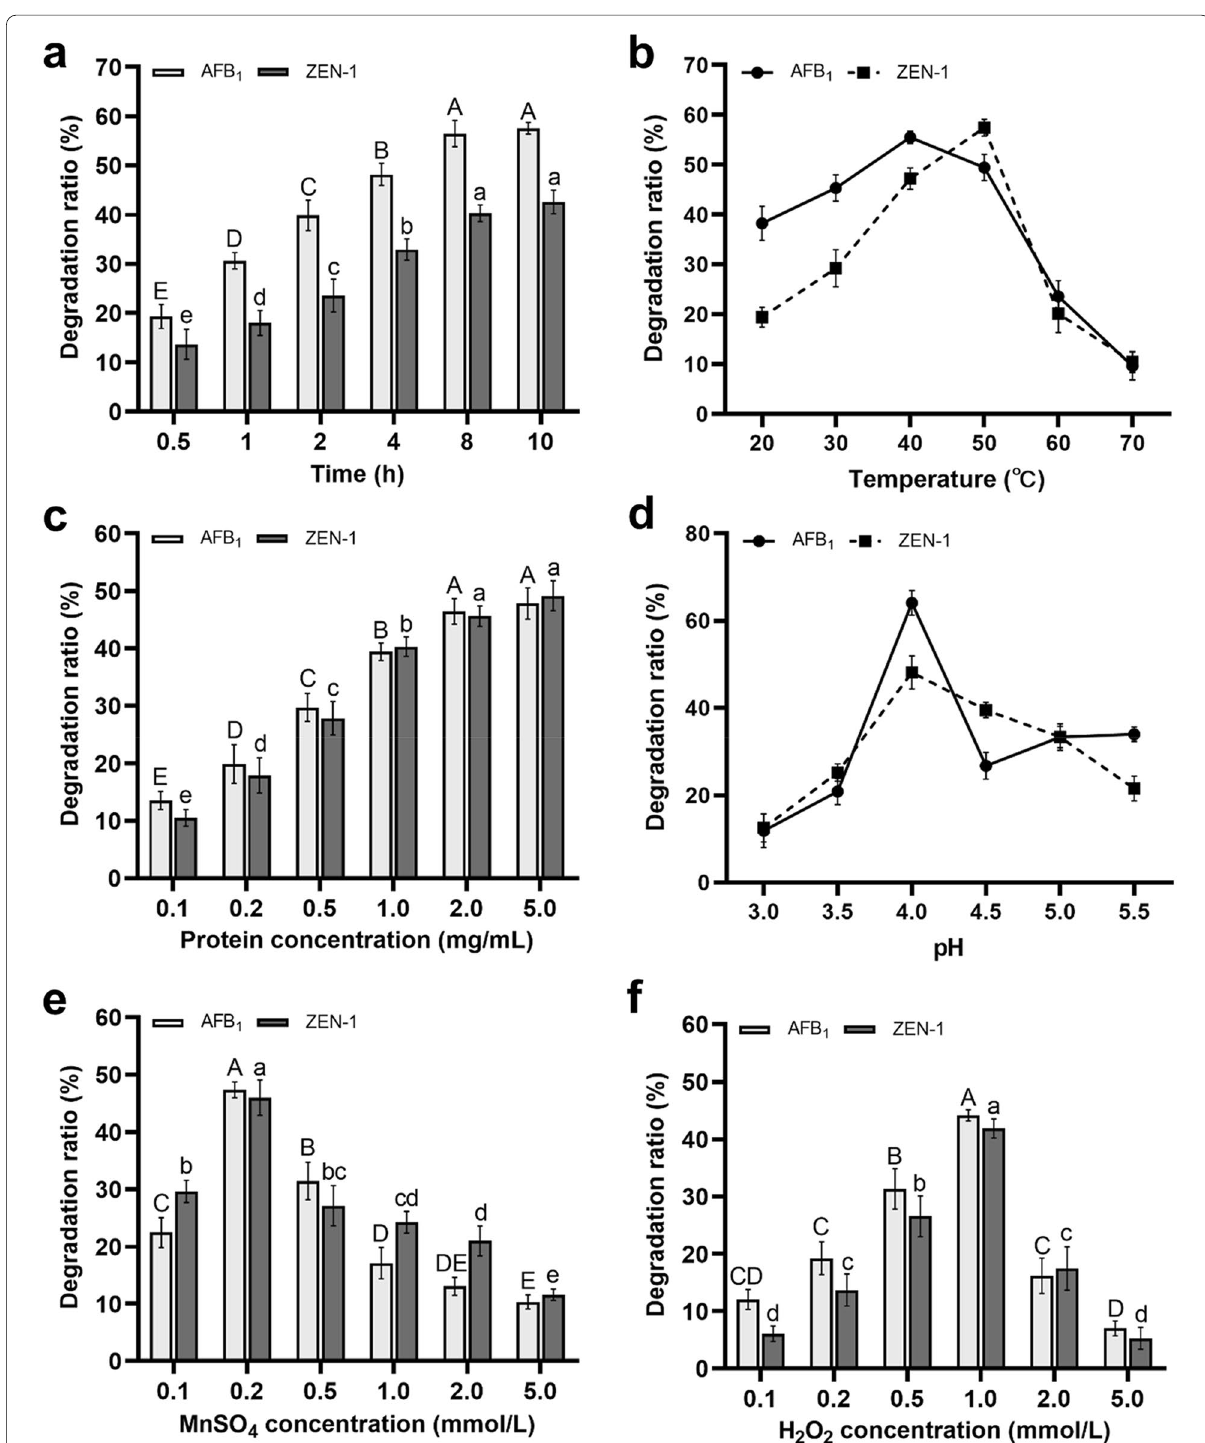
Fig. 4 Degradation of AFB 1 and ZEN by ZPF1 under different conditions in reaction system 1. a–f were the effects of time, temperature, protein concentrations, pH of buffer, concentrations of MnSO 4 and concentrations of H 2 O 2 . Different letters above the histogram were significant differences ( p <